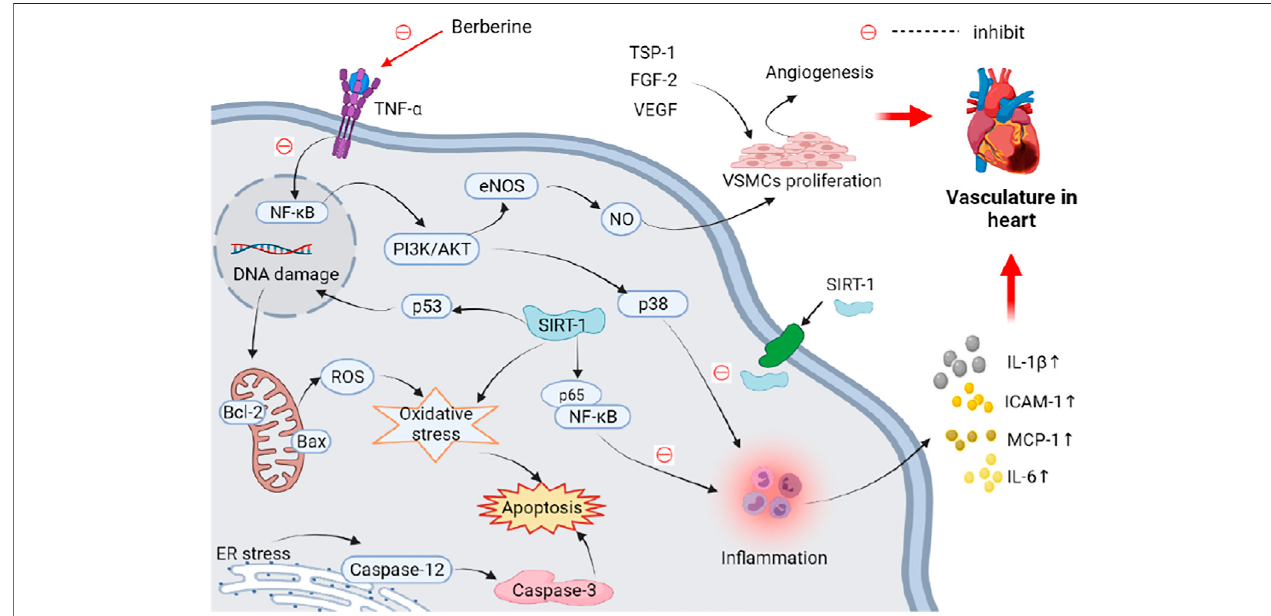
FIGURE 3 | Schematic representation of the possible mechanism of anti-vasculature in heart activity of berberine. Elevated miR-29b can activate the Akt signaling pathway, thus promoting angiogenesis and cell proliferation and migration to improve vasculature in heart. Increased in fl ammation, oxidative stress, and ER stress can induceapoptosisofvascularendothelialcells.Theseadverseeffectsonvasculatureinheartcanbereversedbyberberine.Abbreviations:Akt,proteinkinaseB;Bax,Bcl- 2 associated X protein; Bcl-2, B-cell lymphoma 2; eNOS, endothelial nitric oxide synthase; ER, endoplasmic reticulum; FGF-2, fi broblast growth factor 2; ICAM-1, intercellularadhesionmolecule1;IL-1 β ,interleukin1 β ;MAPK,mitogen-activatedproteinkinase;MCP-1,monocytechemoattractantprotein1;NF- κ B,nuclearfactor κ B; PI3K, phosphoinositide 3-kinase; ROS, reactive oxygen species; SIRT-1, silent information regulator 1; TNF- α , tumor necrosis factor α ; TSP-1, thrombospondin 1; VEGF, vascular endothelial growth factor; VSMCs, vascular smooth muscle